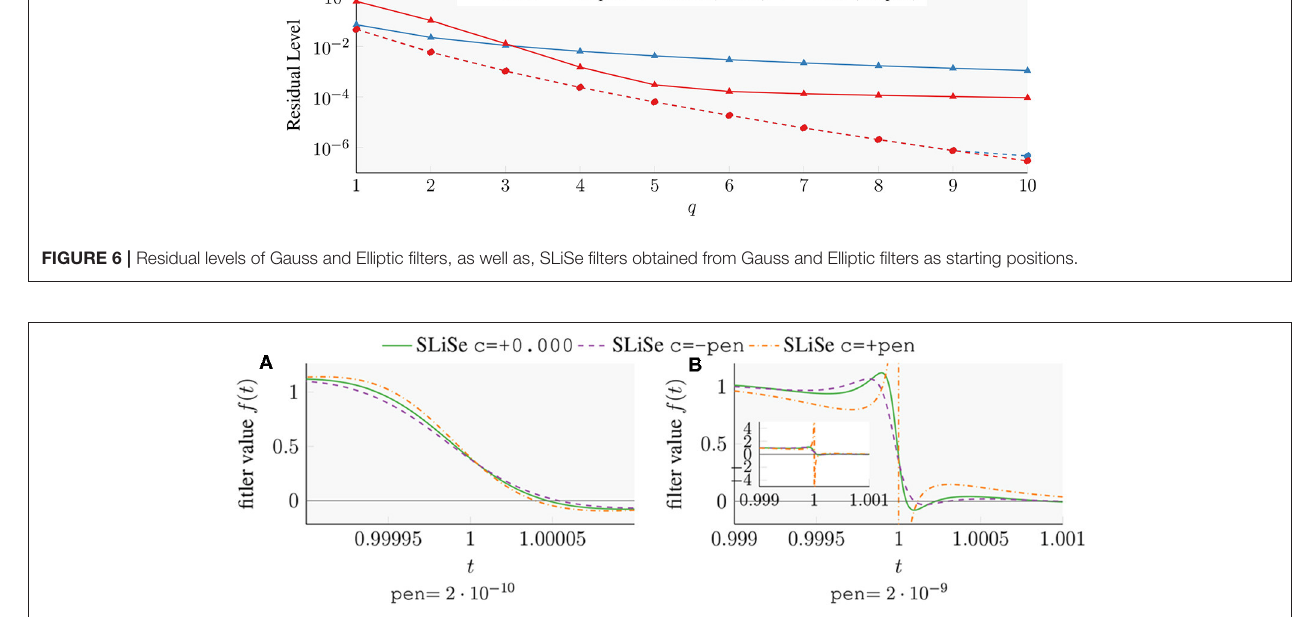
FIGURE 7 | Examples of filters obtained via penalty terms. (A) An appropriately sized penalty parameter yields filters of different steepness. (B) Too large a (positive) penalty parameter results in a pole on the real axis.